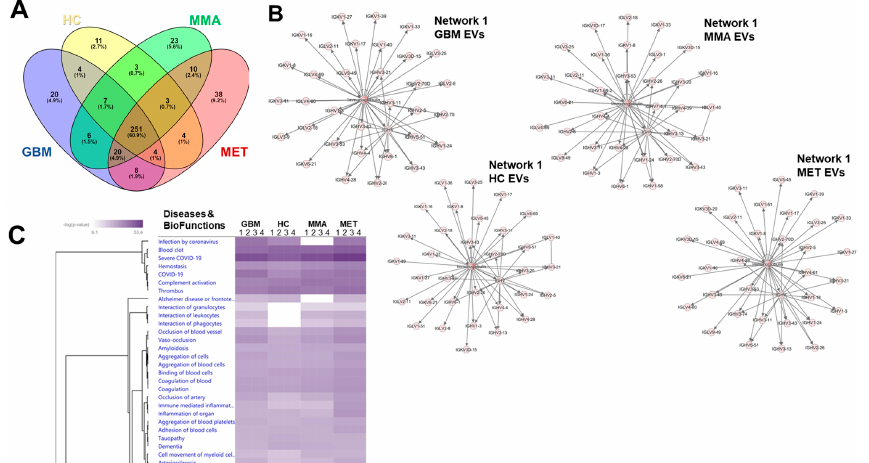
Figure 6. Venn diagram Ingenuity Pathway Analysis (IPA) readouts of plasma EV proteomes. ( A ). Venn diagram showing overlapping and unique protein numbers from each plasma EV category. ( B ). Top networks derived from IPA Core Analysis for each plasma EV proteome showing the pre- dominance of immunoglobulin networks (Networks were all entitled “Cancer, Infectious Disease, Organismal Injury and Abnormalities”; scores = 65–67; 33 focus molecules). ( C ). Comparison Anal- ysis conducted on all four plasma EV datasets from four different patients or controls showing hi- erarchical clustering of the top 30 Disease and BioFunction significant categories. This is a partial representation; the full table of all 636 categories is found in Table S5. A deeper analysis of the differentially expressed proteins found when comparing HC plasma EVs vs. GBM patient plasma EVs (Figure 7A) shows that, despite the relatively small numbers of proteins on input, hierarchical clustering of the comparative canonical pathways finds significant differences in many pathways (Figure 7B). Network interac- tomes reveal cancer signaling pathway nodes for the over-represented proteins in the plasma EVs of GBM patients, with another immunoglobulin-centered network for HC EV plasma EVs (Figure 7C,D). These results suggest that immunoglobulins associated with plasma EVs from patients with GBM may play important roles in EV activities, and the differentially expressed EV proteins tie to prominent cancer signaling pathways (AKT1; p38MAPK; ERK1/2). In the Supplementary Files, Volcano plots for comparing up- and down-regulated proteins in GBM and HC purified IgG and EV samples are presented in Figures S1 and S2, respectively. The patient demographics are presented in Table S1. The protein concen- trations of samples used for Mass Spectrometry are shown in Table S2. The proteomic results for EV and IgG are listed in Tables S3 and S4, respectively. The complete list of IPA comparison analysis of all 4 types of EV samples is available in Table S5.